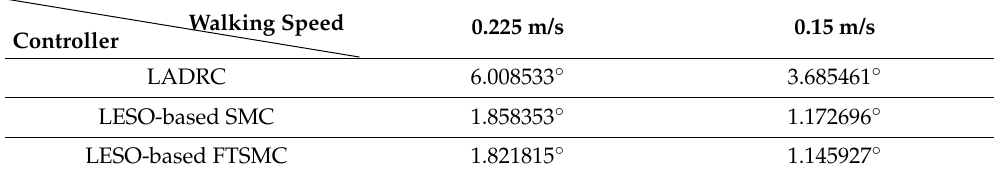
Table 1. RMSE of hip joint trajectories for LADRC, LESO-based SMC, LESO-based FTSMC. Walking Speed